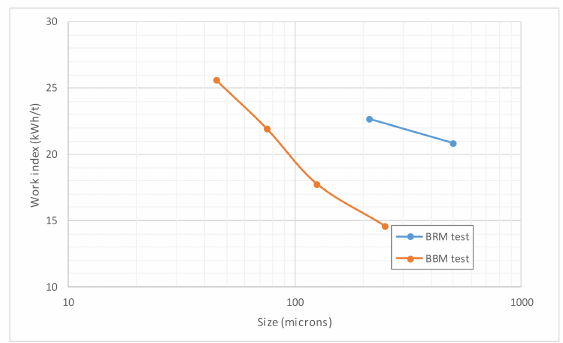
Figure 2. Variation of BBM and BRM w i values with P 100 , Penouta tailings pond ore.